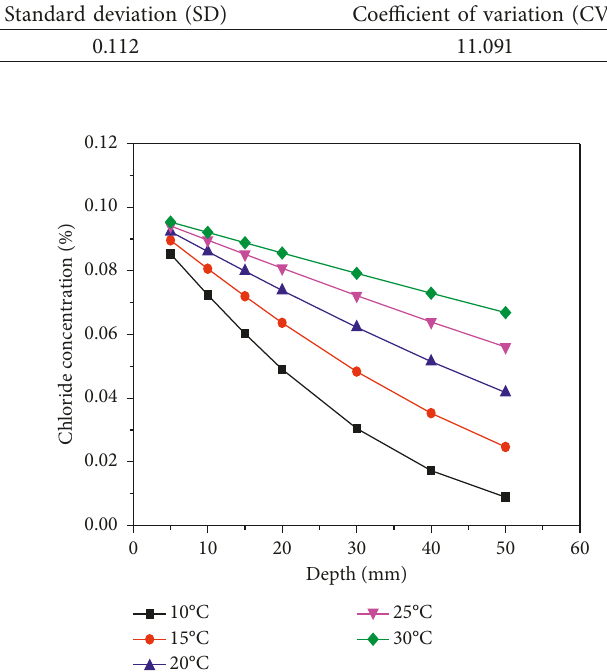
Figure 6: Calculated and measured results of the chloride profile for Haimen Bridge.